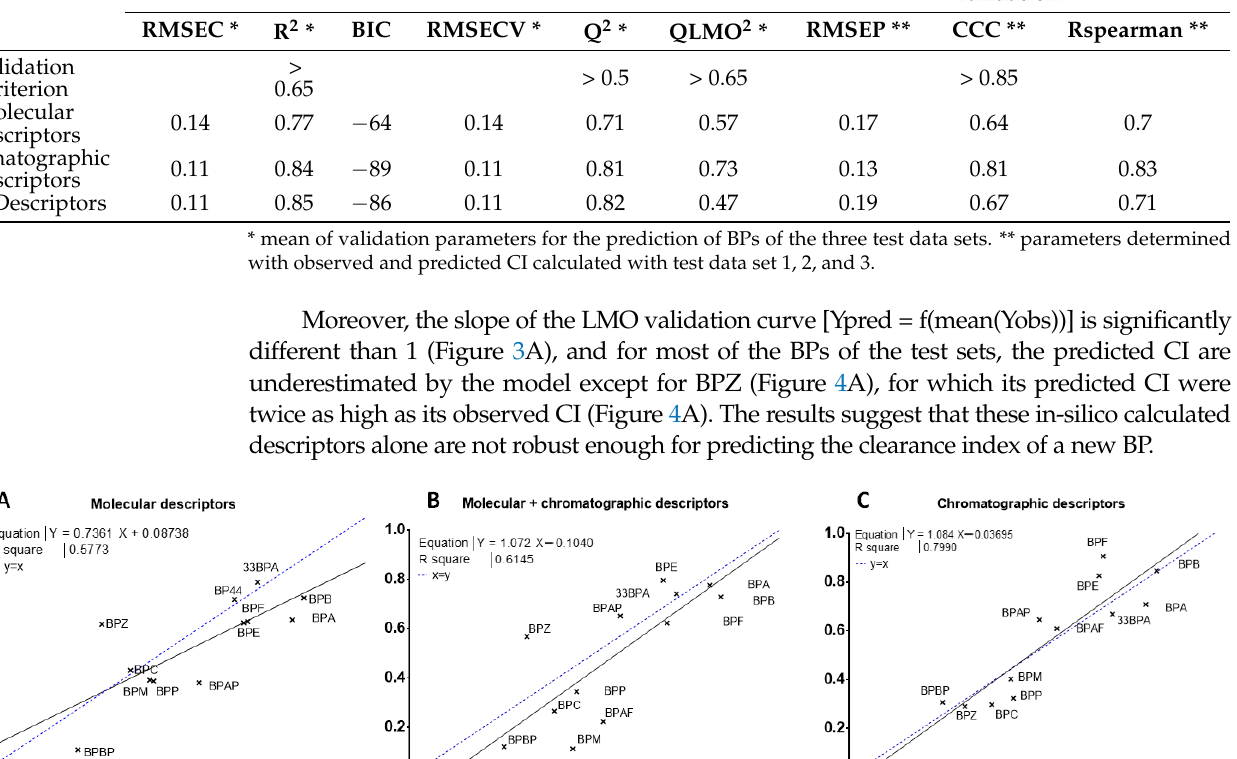
Table 2. Statistical results of the QSAR for the three selected models built with either molecular, chromatographic, or combined descriptors.